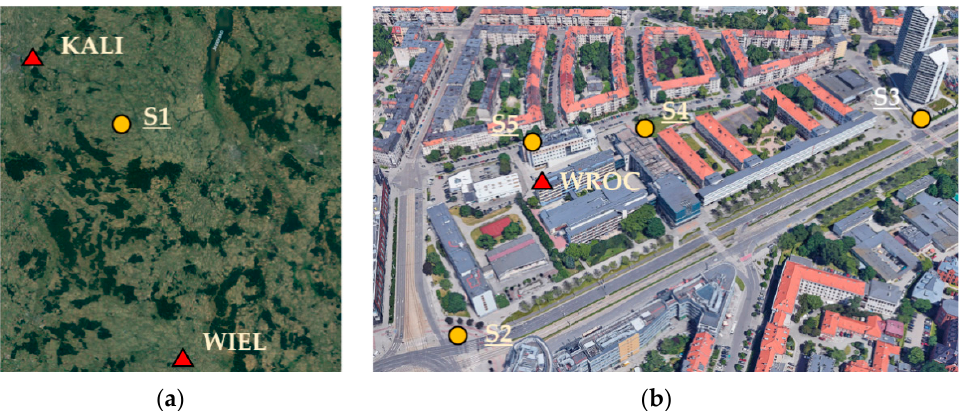
Figure 1. Location of control points and reference stations in ( a ) countryside and ( b ) urban areas.